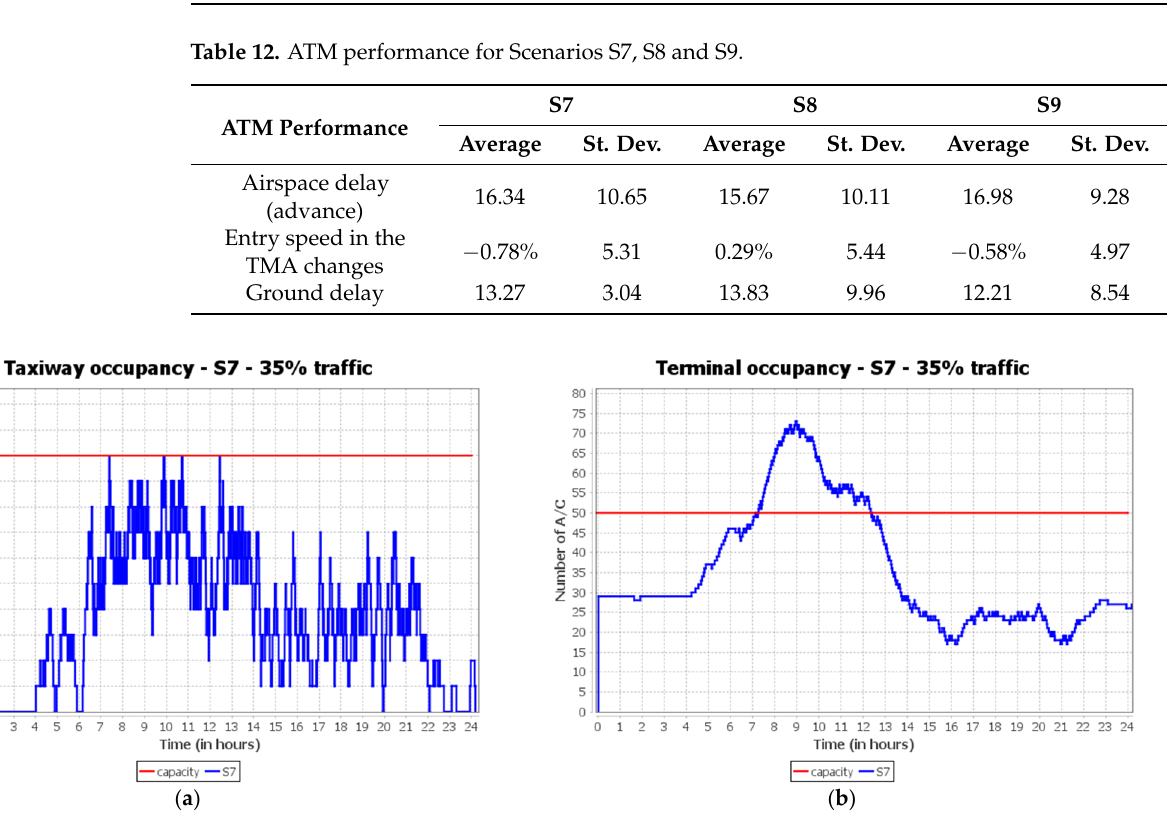
( b ) Figure 14. Taxiway ( a ) and terminal ( b ) occupancy scenario S9. Regarding the ATM performance, it is interesting to look at the ground delay, as it is the factor that characterizes these scenarios. As expected, the average values of ground delay for these three scenarios have increased compared to the ones of the other previous scenarios. We notice that scenario S7 has a lower value of standard deviation compared